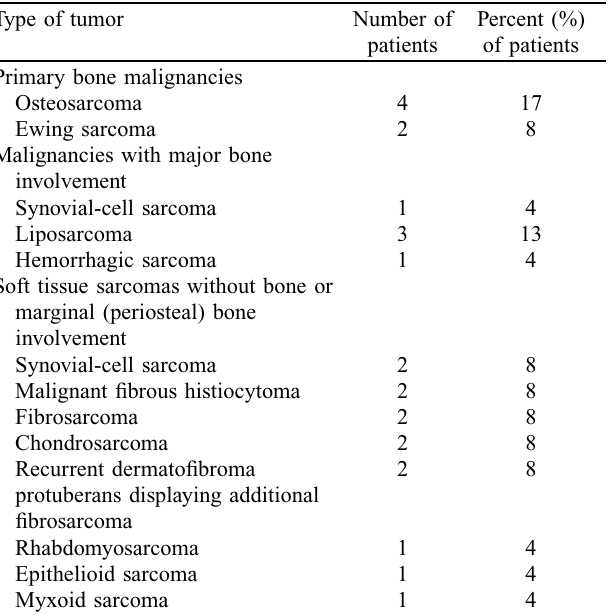
Table 1. Histopathological diagnosis regarding the study population (surgical